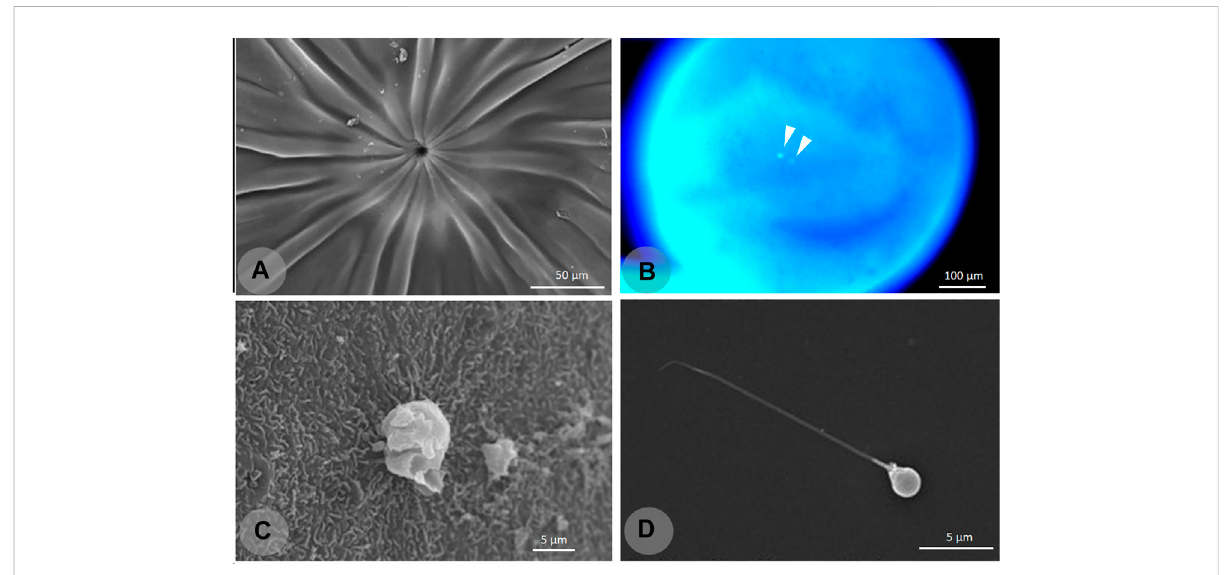
FIGURE 2 Cytological and ultrastructural images from the oocytes and spermatozoa of the yellowtail tetra Astyanax altiparanae . Ultrastructural analysis (scanning electron microscopy,SEM) of the oocyte micropyle (A) showing grooves that guide the sperm entry. DAPI staining of the fertilized oocyte showing male and female pronucleus (B) .Secondpolar body extrusion (C) .Spermatozoon ofthe yellowtail tetra (D) . This information wasimportant to develop chromosome set manipulation